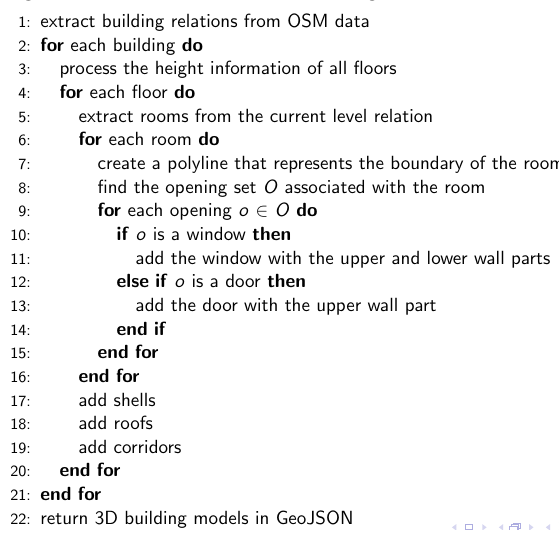
Figure 3: The proposed algorithm for 3D construction of building models.